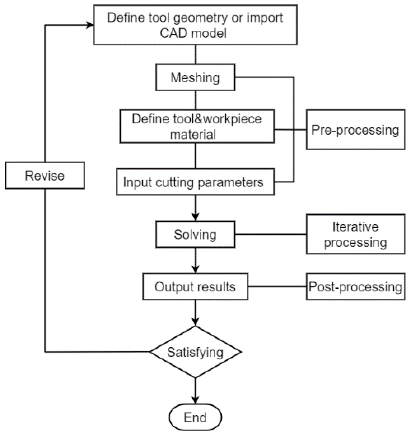
Figure 6. Finite element simulation process diagram of AdvantEdge.